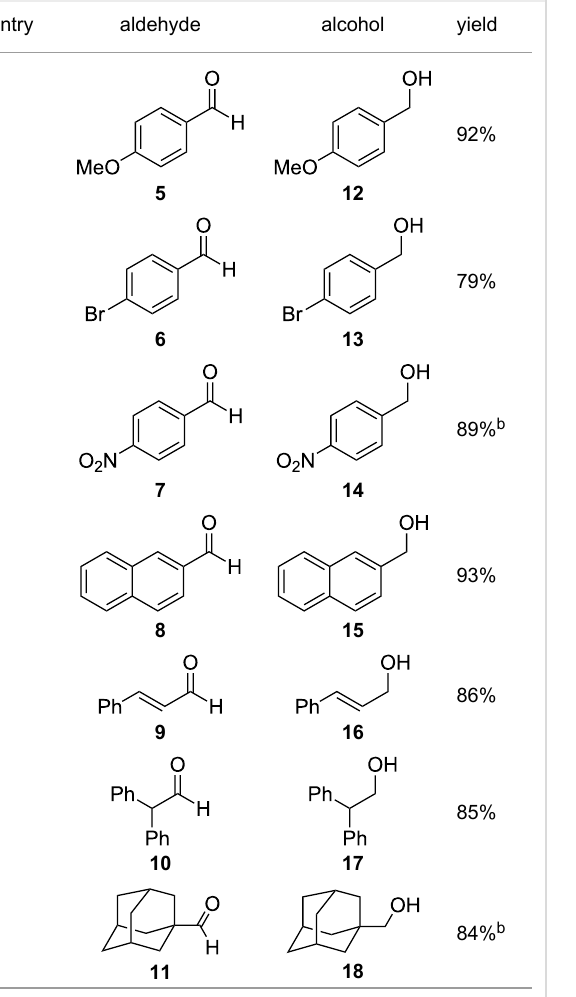
Table 1: Reductions of aldehydes by diMe-Imd-BH 3 ( 1 ) and acetic acid. a entry aldehyde